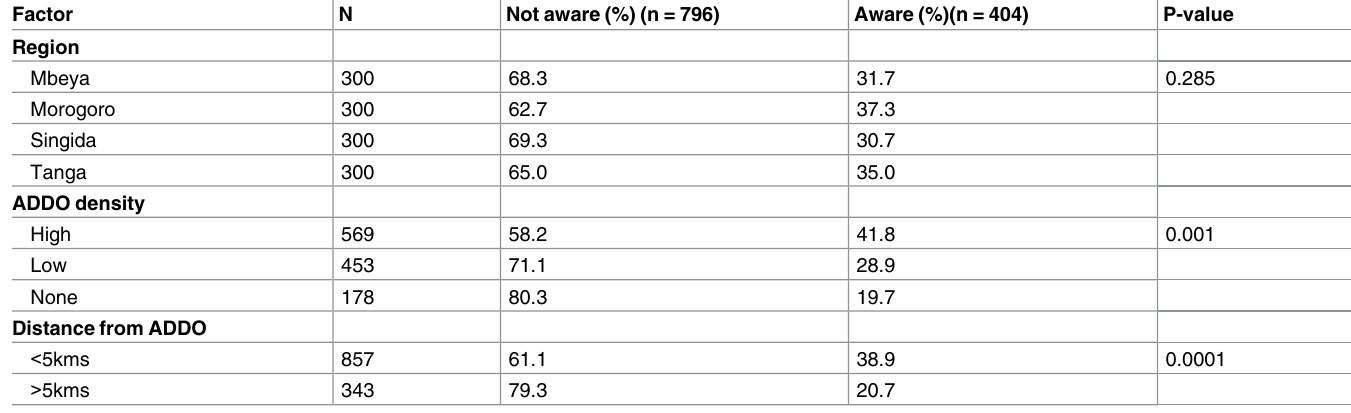
Table 1. Awareness of antimicrobials as a type of medicine by region, ADDO density, and distance from ADDO. Factor N